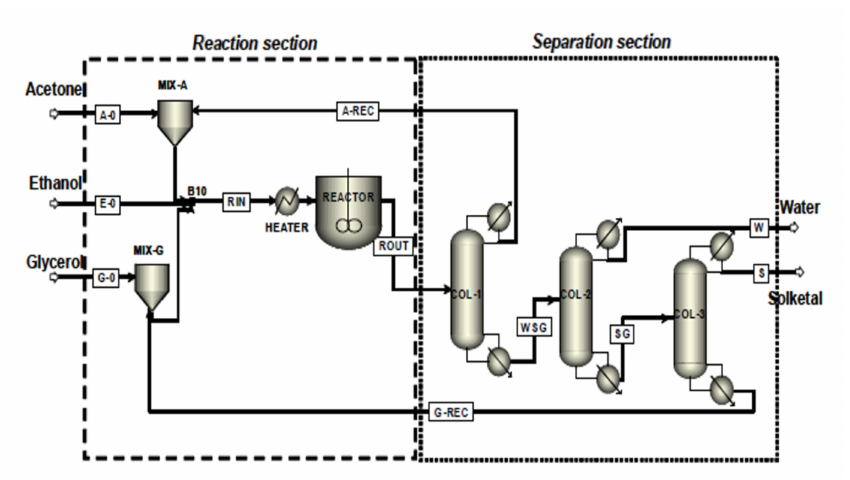
Figure 2. Synthesis of solketal via industrial ketalization process. Reproduced with the permission from [30], Springer,